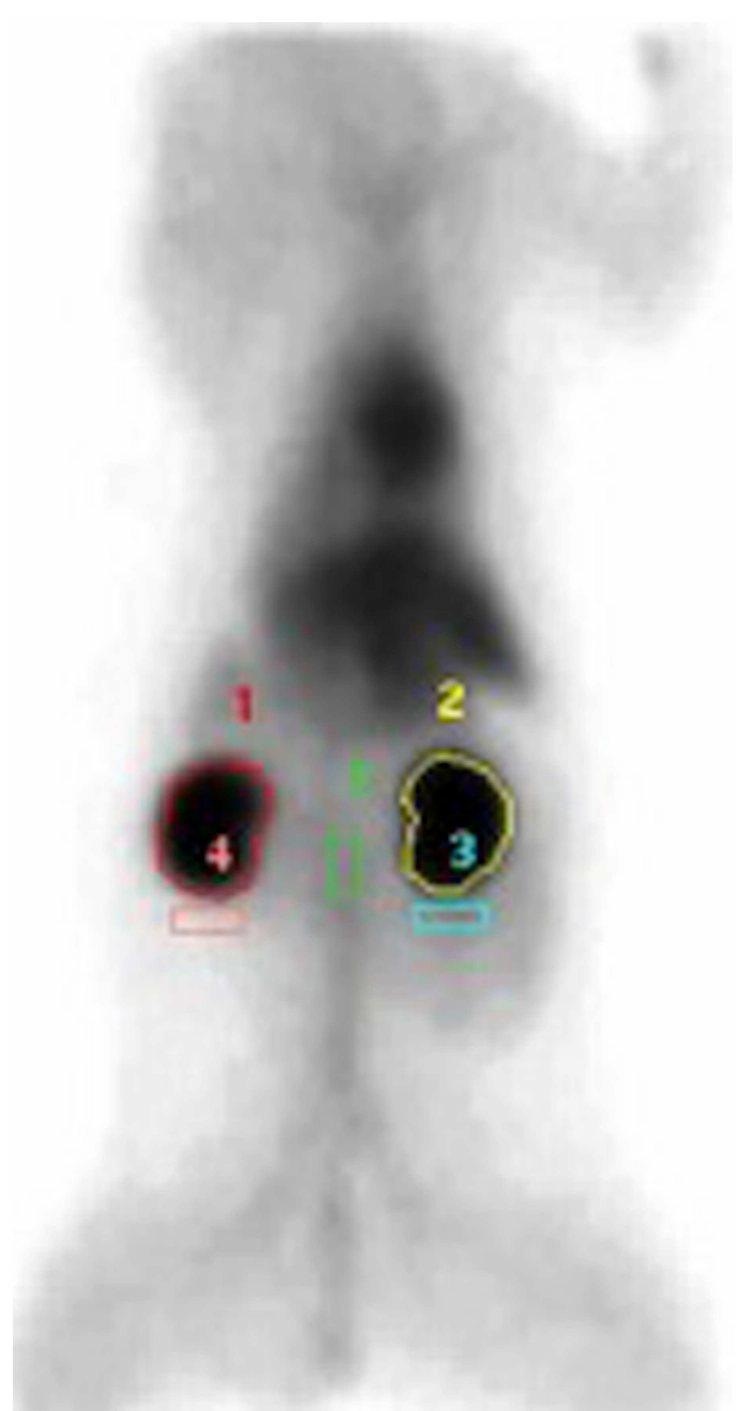
Fig 2. Summed dynamic dorsal images from a cat injected with 99m Tc-MAG 3 . Note the ROIs drawn on both kidneys with the rectangularbackground placed caudalto the kidneys and a rectangularROI drawn on the aorta at the level of the